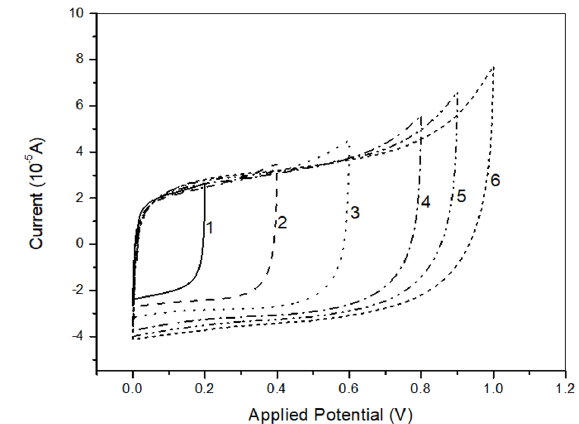
Figure 1 : Cyclic voltammograms of EDLC [(1) 0.001-0.2 V, (2) 0.001-0.4 V, (3) 0.00 -0.6 V, (4) 0.001-0.8 V, (5) 0.001-0.9 V, (6) 0.001-1.0 V] at a scan rate of 10 mV s -1 .